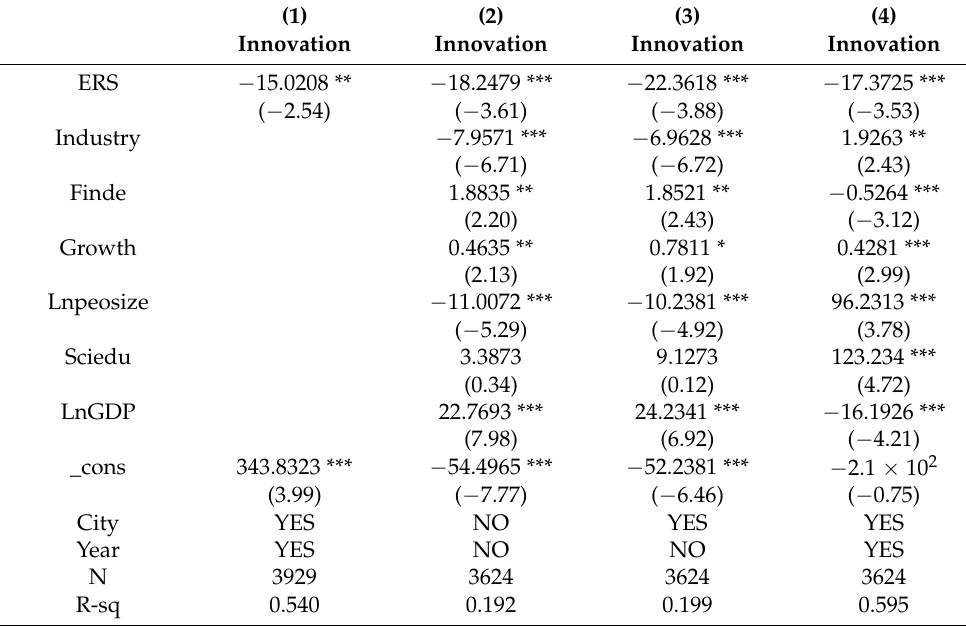
Table 4. Robustness test results of GDP constant price.